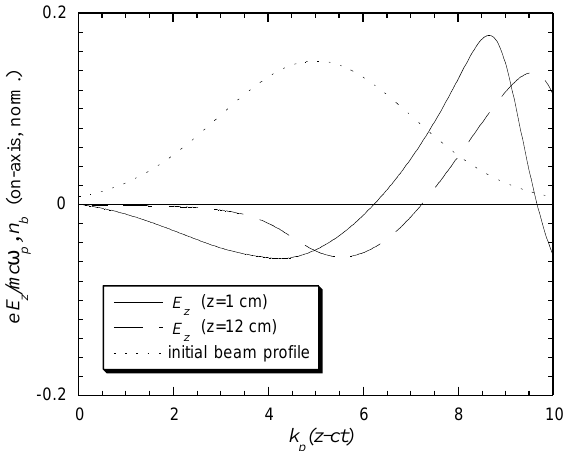
FIG. 12. The initial on-axis beam profile, as well as longitu- dinal wake field at the beginning of the plasma (cid:3) z (cid:1) 1 cm (cid:4) and end of the plasma (cid:3) z (cid:1) 12 cm (cid:4) , from simulation. The wakefield amplitude and phase changes are due to beam-head